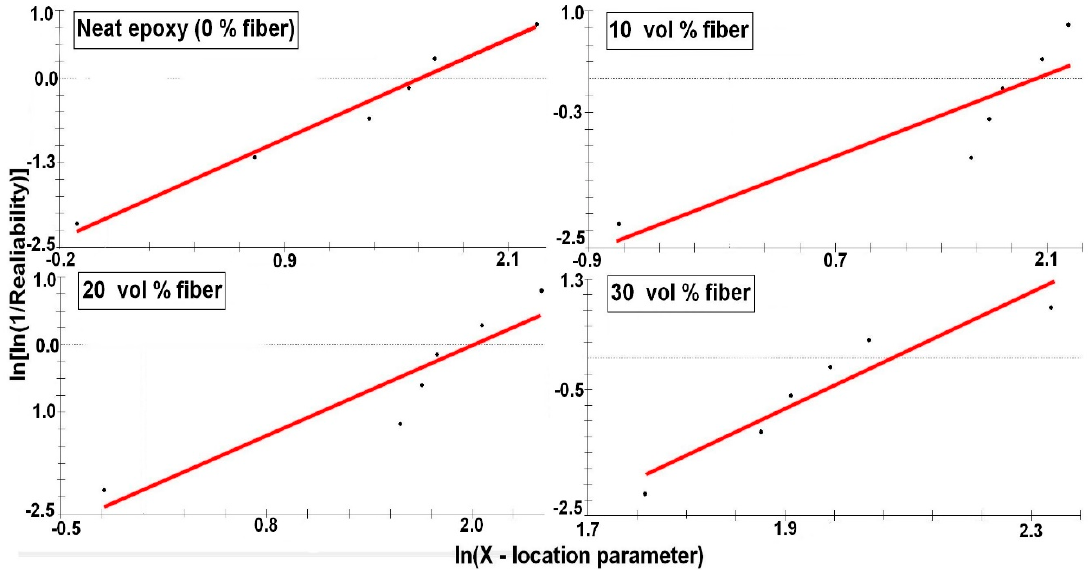
Figure 8. Elastic modulus Weibull plots for the epoxy composites reinforced with di ff erent volume Figure 8. E lastic modulus Weibull plots for the epoxy composites reinforced with different volume fractions of caranan fractions of caranan fiber.